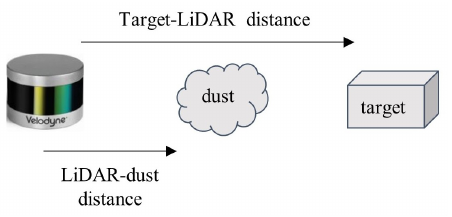
Figure 1. Design variables to generate experimental conditions.